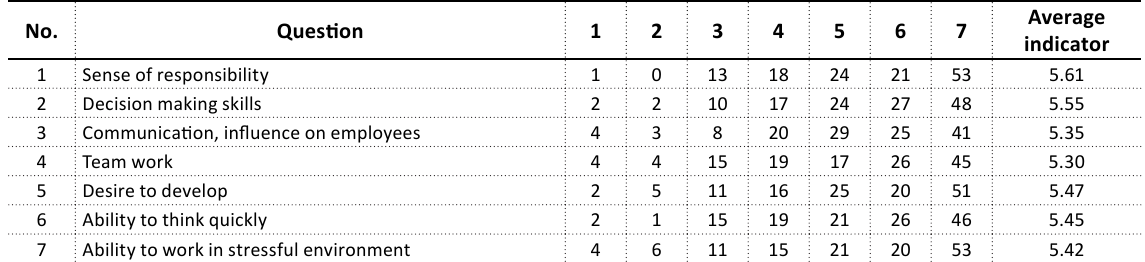
Table 1. The characteristic features of the employed men are evaluated by 7-point system (1 point – very bad; 7 points – very